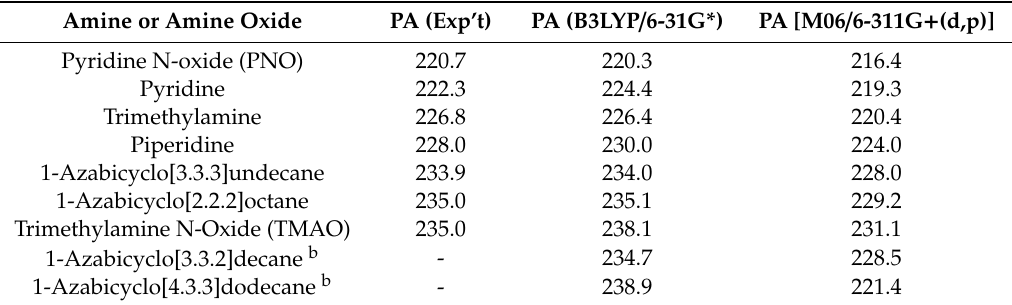
Table 5. Experimental and calculated proton a ffi nities (PA, kcal / mol) of some amines and amine oxides investigated in this study. These data are from a compendium a : values in kJ / mol are divided by 4.184 kJ / kcal to provide data in kcal / mol. Amine or Amine